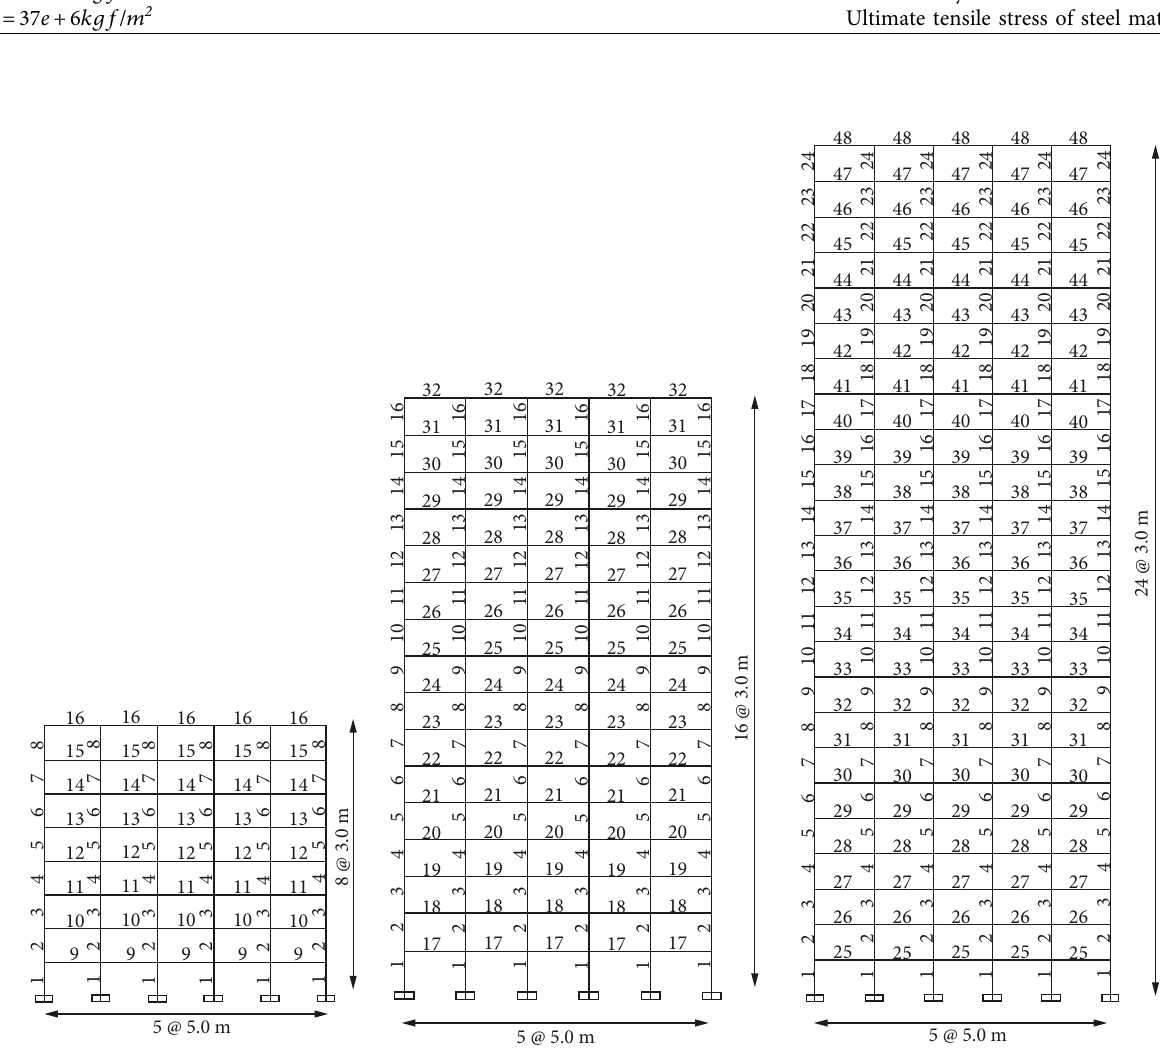
Figure 10: Typology of the designed models of 8-, 16-, and 24-story